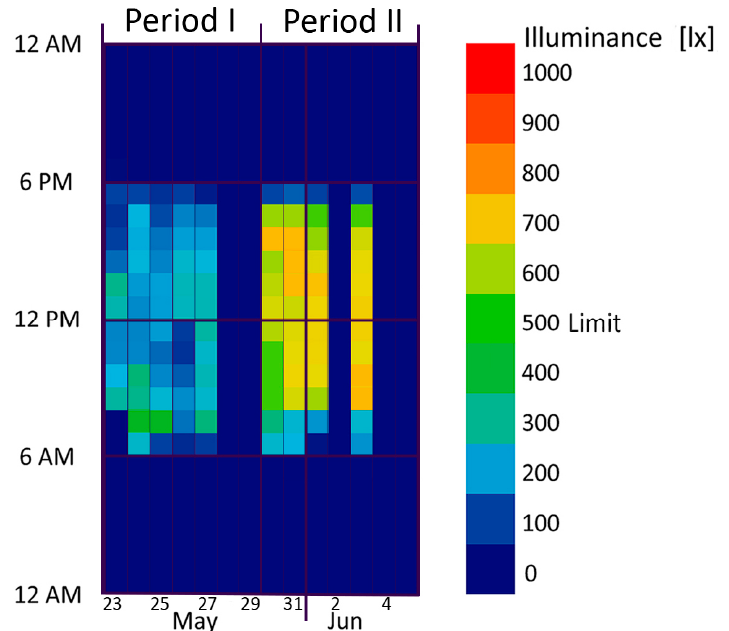
Figure 10. Hourly average data for manual control (period I, 23–29 May) and automatic control (period II, 30 May–5 June): illuminance level.